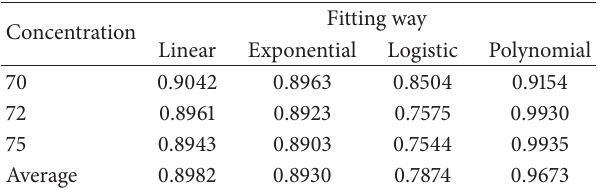
Table 3: Multiple correlation coefficient result of different fitting methods.